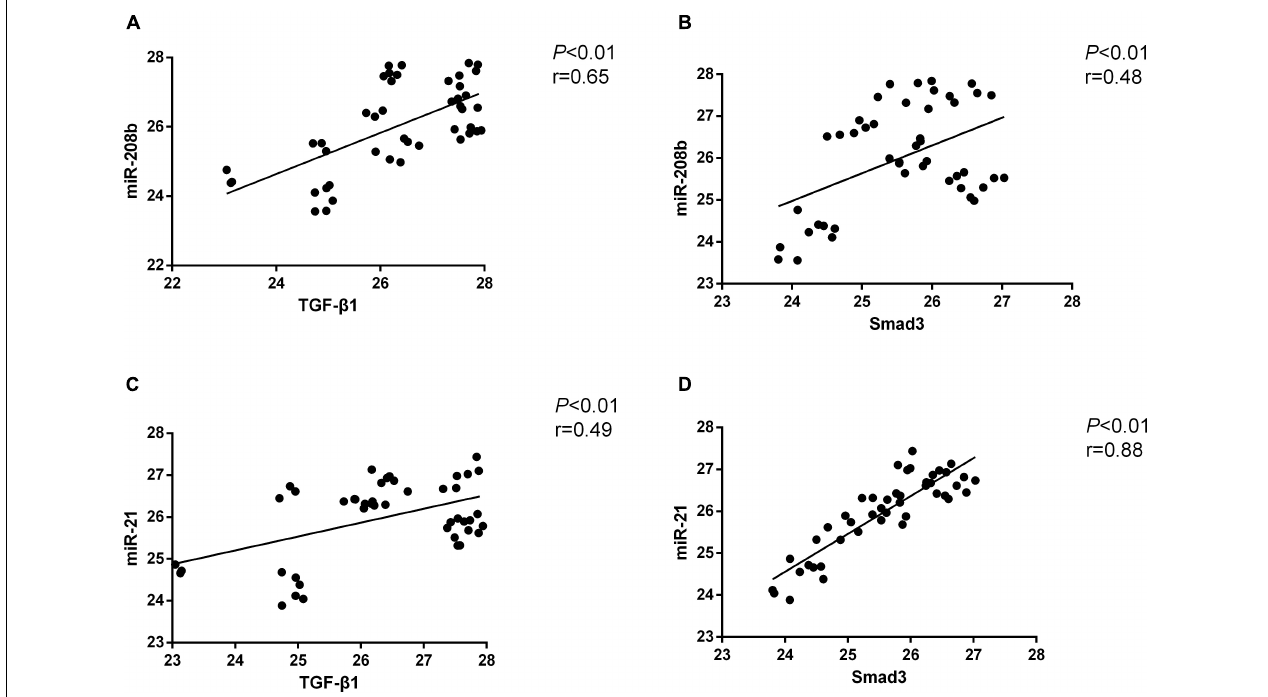
FIGURE 3 | The correlation between miR-208b/miR-21 and TGF- β 1/Smad-3. (A) Positive correlation between miR-208b and TGF- β 1; (B) positive correlation between miR-208b and Smad-3; (C) positive correlation between miR-21 and TGF- β 1; (D) positive correlation between miR-21 and Smad-3. TGF- β 1, transforming growth factor- β